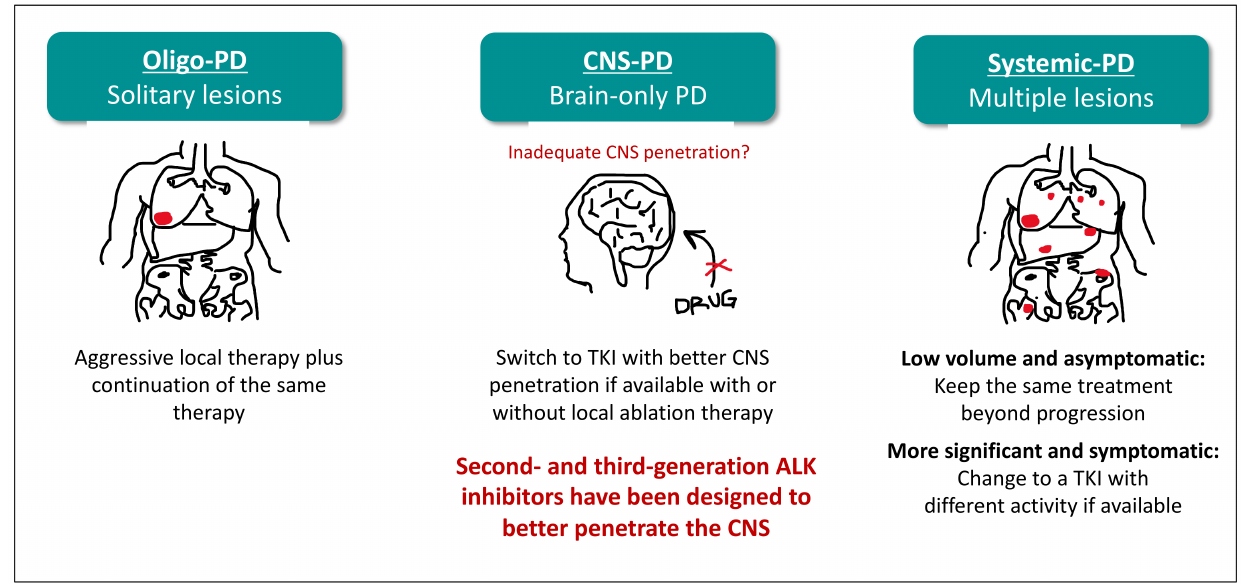
Figure 4. Different therapeutic strategies in the management of advanced ALK-positive NSCLC, according to pattern and site of